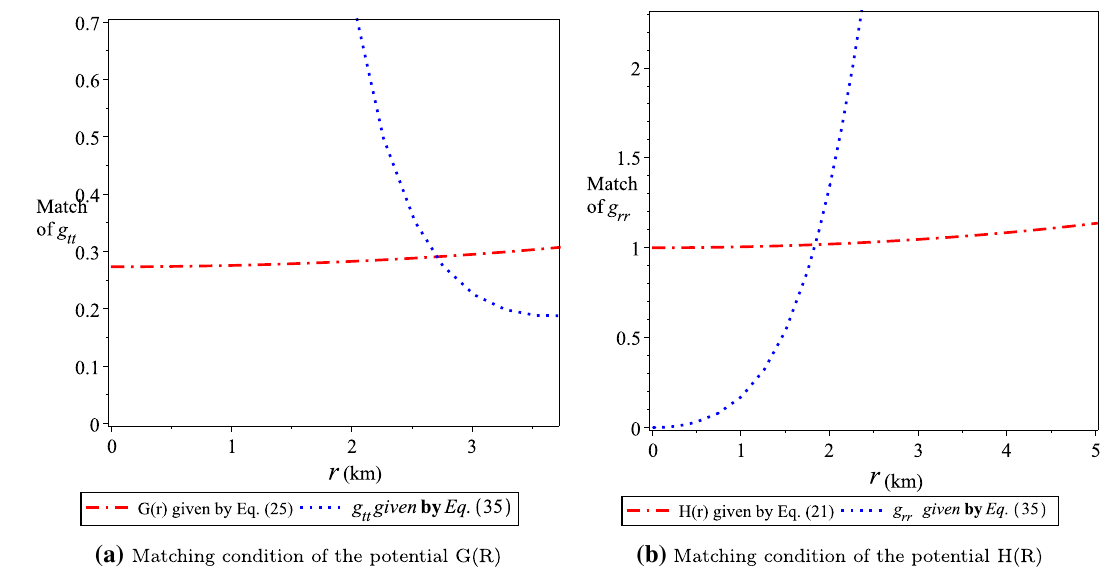
Fig. 7 Plot of the radial coordinate r in Km versus the weak, null, strong and dominant energy conditions from (26) using the constants constrained by PSR J 1614-2230 data